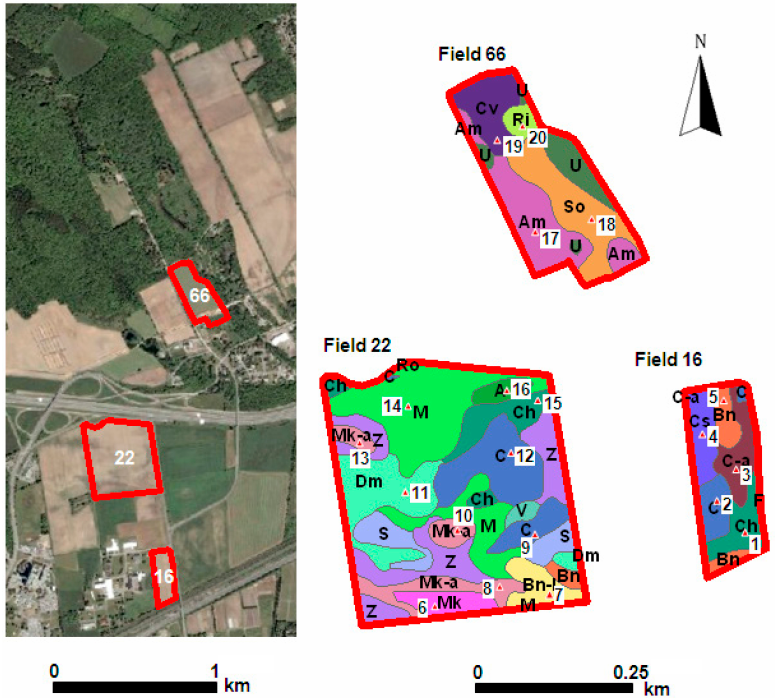
Figure 4. Experimental fields with different soil